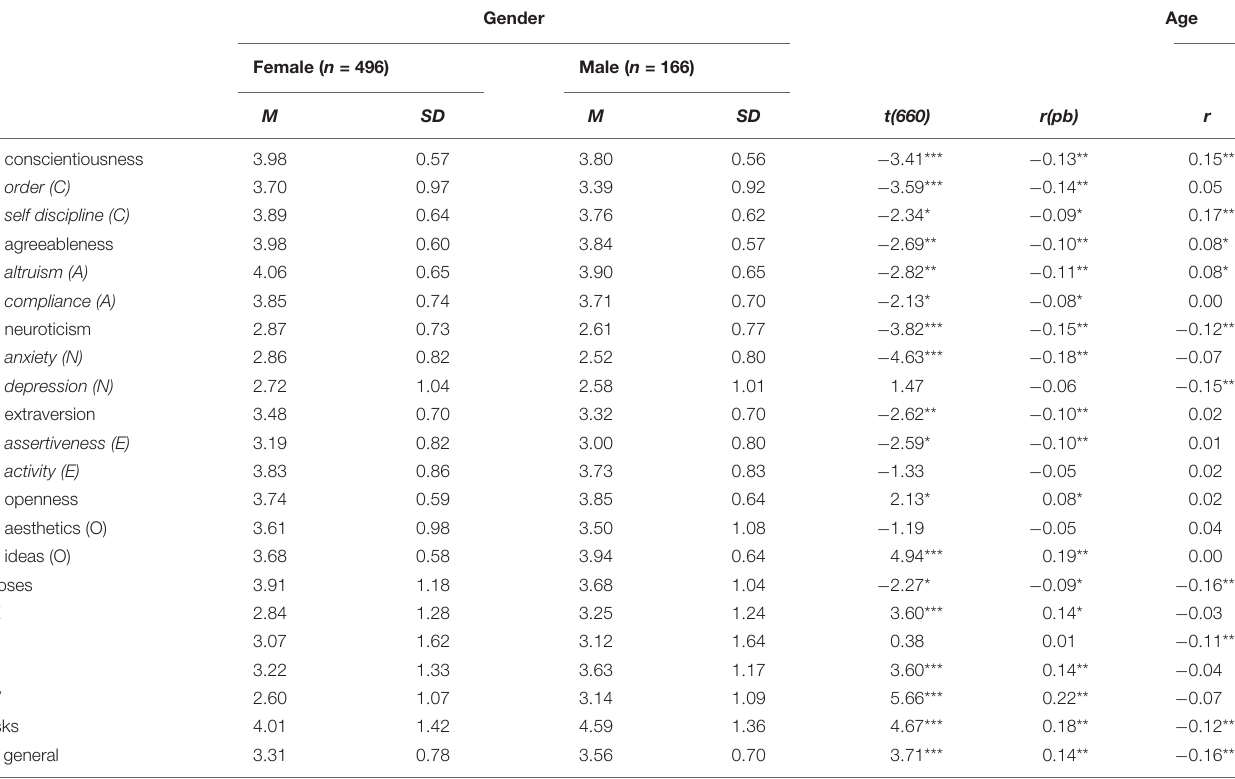
TABLE 5 | Means and standard deviations of the FP scores for men and women and their correlation with age.